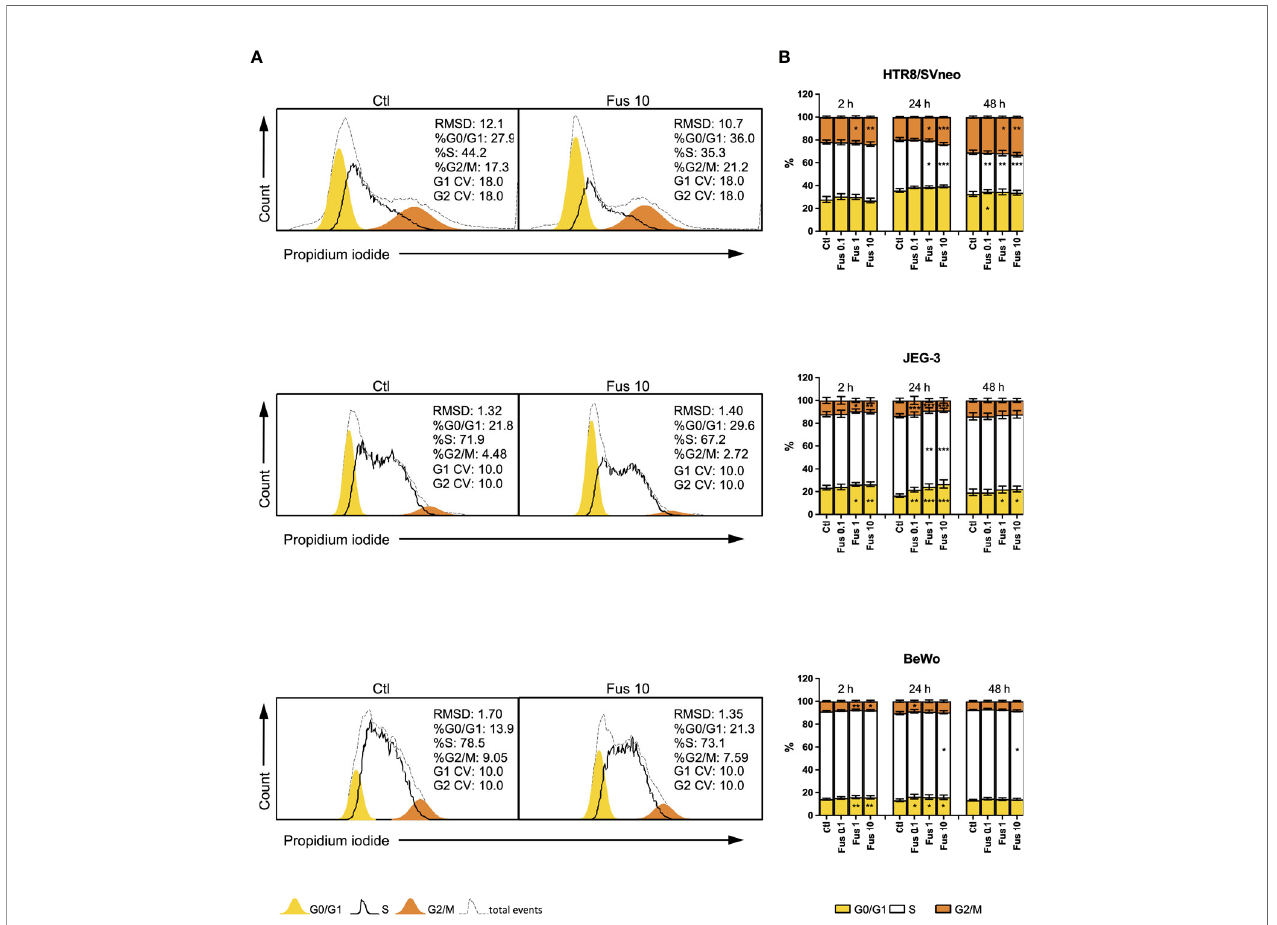
FIGURE 3 | Inactivated F. nucleatum increases the frequency of HTR8/SVneo cells in G2/M phase and JEG-3 and BeWo G0/1 phase. HTR8/Svneo, JEG-3 and BeWo were stimulated with different concentrations of F . nucleatum . Cell cycle analysis was performed after 2, 24 or 48 h. Representative cell cycle analysis of unstimulated control and Fus10 (A) . Bar graphs show percentages of cells in the different cell cycle phases (B) . Data are presented as mean ± SEM. *p adj < 0.05; **p adj < 0.01; ***p adj < 0.001 as analysed by Repeated Measures ANOVA with Dunnett ’ s multiple comparison post test, comparing each treatment against the corresponding control. Experiments were performed 6 times in triplicate. Each point represents the mean value of the replicates for each experiment. RMDS, Root Mean Square Deviation; G0/G1 and G2/M main peak modeled as a Gaussian distribution, S calculated; CV, Coef fi cients of Variation; Ctl, control; Fus, ratio of F. nucleatum to cell